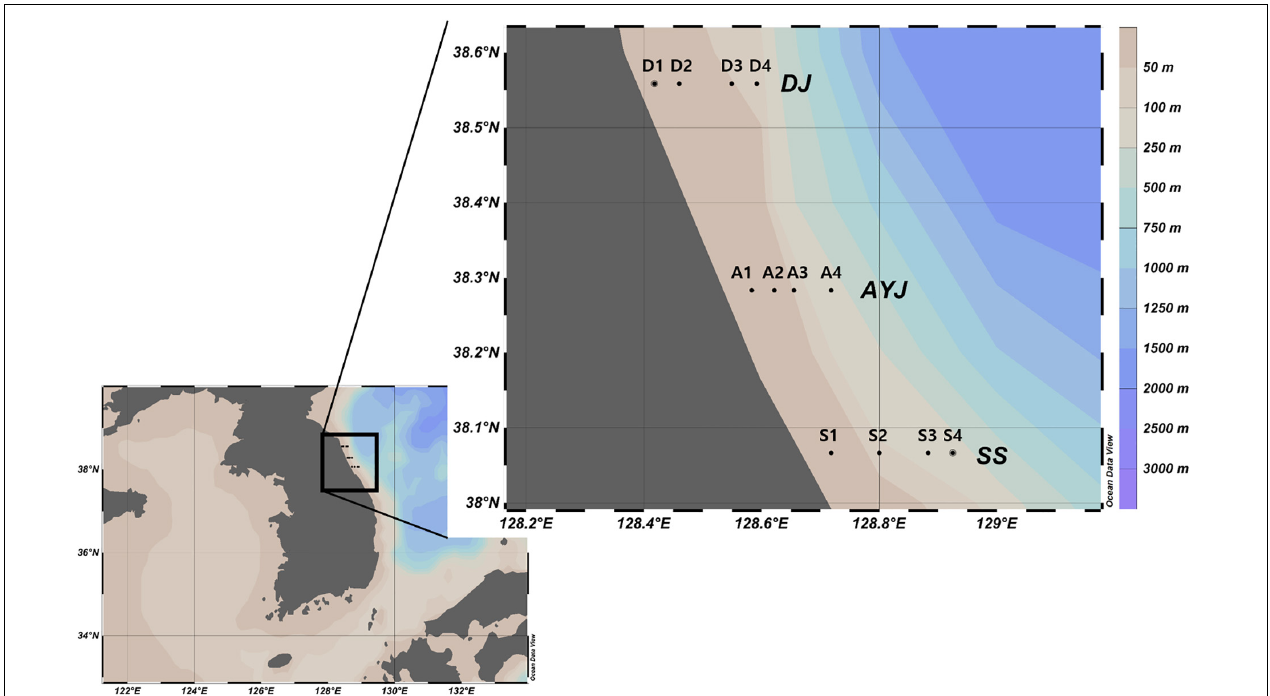
FIGURE 3 | Sample collection stations. The 12 sample collection stations were the coastal waters of three cities including Daejin (D1, D2, D3, and D4), Ayajin (A1, A2, A3, and A4), and Susan (S1, S2, S3, and S4). Maps created using Ocean data view v. 4.7.8 (Schlitzer, 2016, Ocean Data View, https://odv.awi.de).